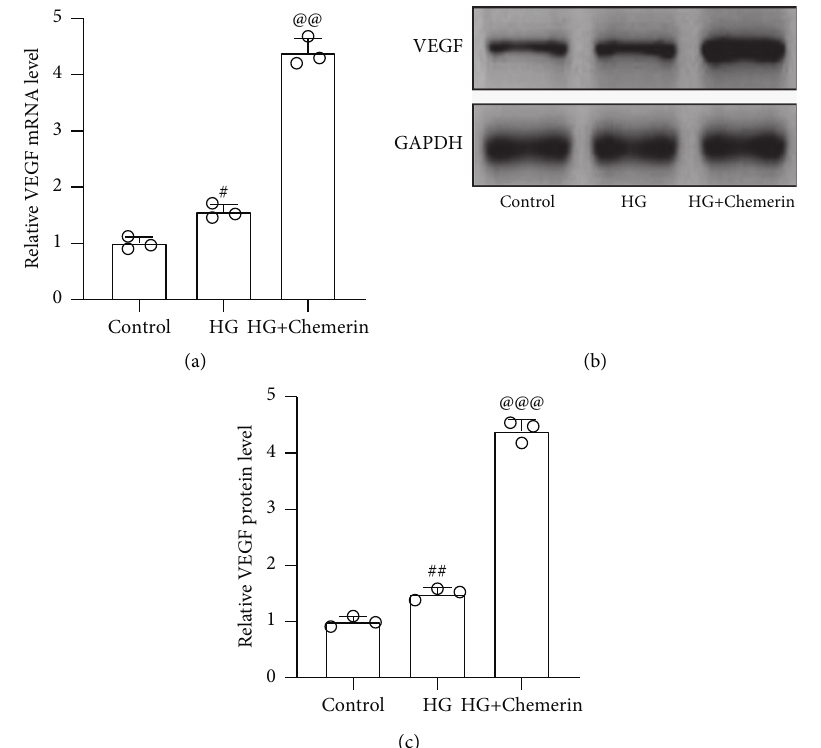
Figure 6: Chemerin aggravated HG-induced VEGF activation in ARPE-19 cells. ARPE-19 cells were exposed to 10nM recombinant human chemerin or (and) 30 mM HG for 24h RT-qPCR was used to measure the mRNA levels of VEGF (a) and western blot was used to measure the protein levels of VEGF ((b) and (c)). N � 3 for each group. # p < 0 . 05 and ## p < 0 . 01 compared to control; @@ p < 0 . 01 and @@@ p < 0 . 001 compared to HG group. One-way ANOVA followed by Dunnett’s T3 multiple comparisons